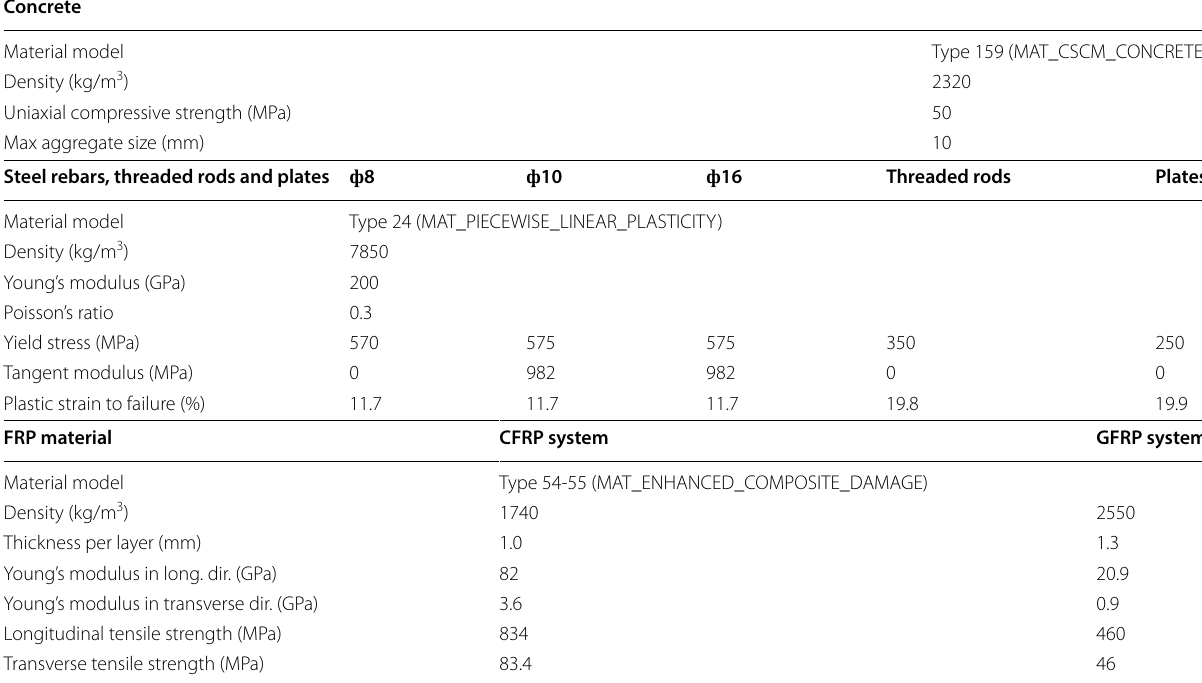
Table 2 Material properties used in the FE modeling.